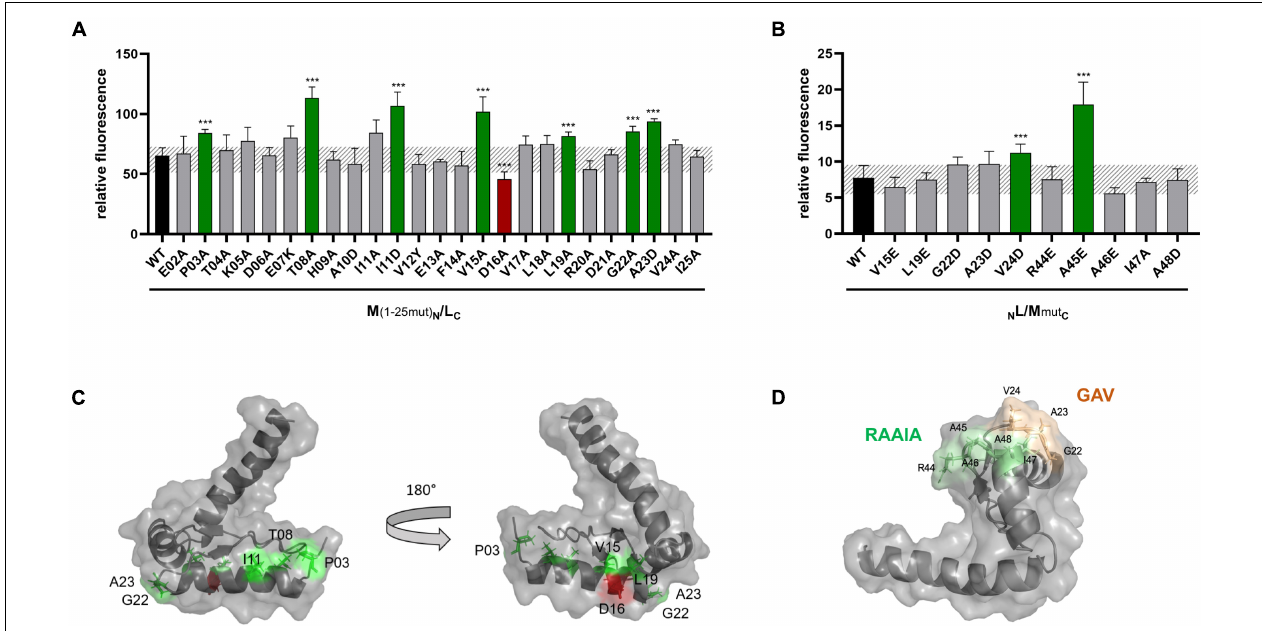
FIGURE 6 | Split-GFP analyses of the interaction of GvpL with variants of GvpM or M1–25. (A) Rf values of L/M1–25 Hfx. volcanii transformants (black) and of various L/M1–25 mut transformants containing single substitutions in fragment M1–25. The respective substitution is indicated at the bottom. Transformants exhibiting a significantly lower fluorescence are labeled in red, and transformants showing a higher fluorescence are in green. (B) Rf values of GvpL and L/M wild type (black) and the various L/M mut transformants. The significance was calculated by Student’s t -test. ∗∗∗ extremely significant = p ≤ 0.001. (C) Homology structure model of GvpM (Winter et al., 2018) showing the location of the aa where a substitution yielded a lower (red) or a higher (green) fluorescence of L/M or L/M1–25 transformants. (D) Location of the GAV and RAAIA motifs in